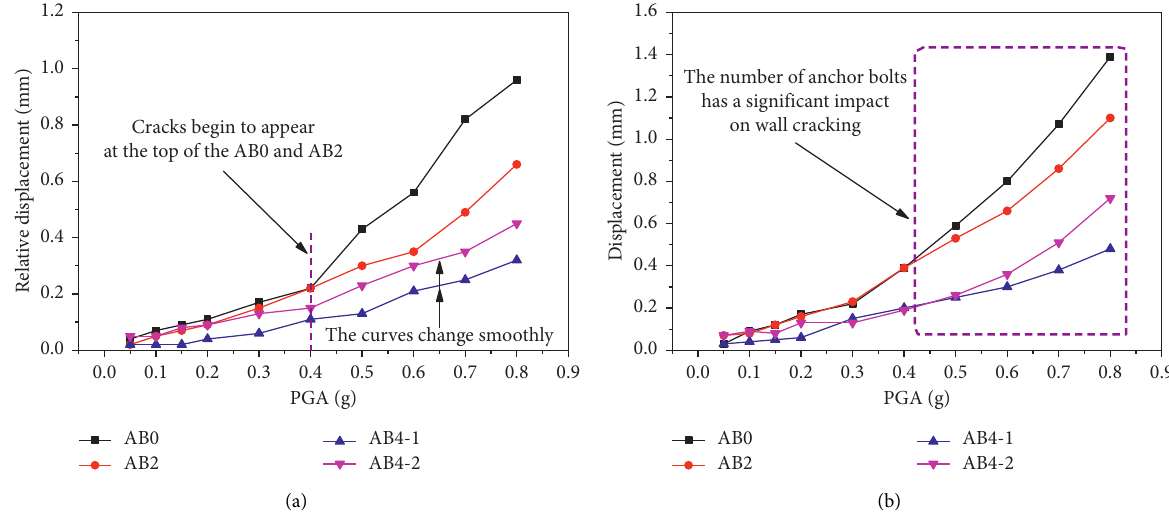
Figure 11: Relative displacement between IDB wall and shear wall. (a) In the middle of the specimen. (b) At the top of the specimen.